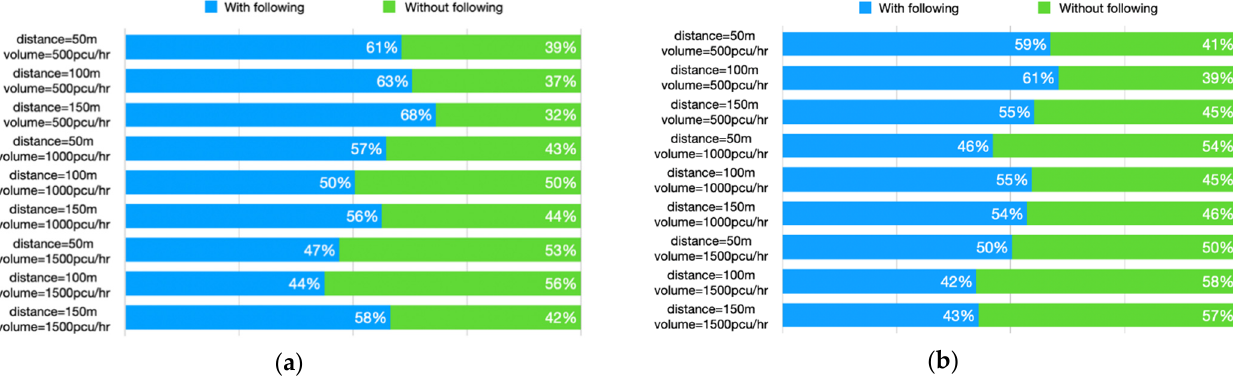
Figure 6. ( a ) Percentage of following time after learning about the school bus regulations; ( b ) percentage of following time if the school bus regulations are not known.